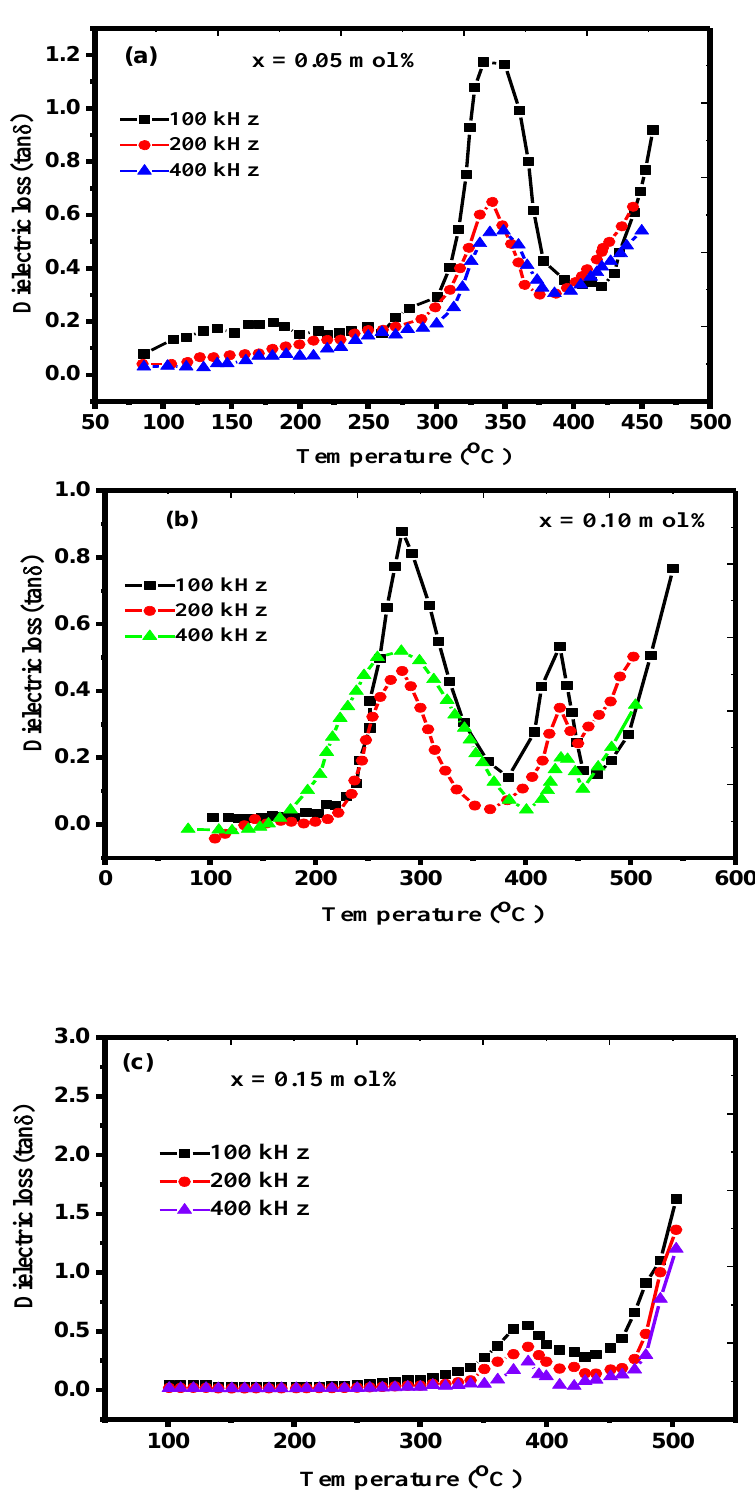
Figure 5. Dielectric loss of Co x :K 2 Ti 6 O 13 ceramics as a function of temperature; ( a ) is for Co 0.05 :K 2 Ti 6 O 13 , ( b ) is for Co 0.10 :K 2 Ti 6 O 13 and ( c ) is for Co 0.15 :K 2 Ti 6 O 13 .